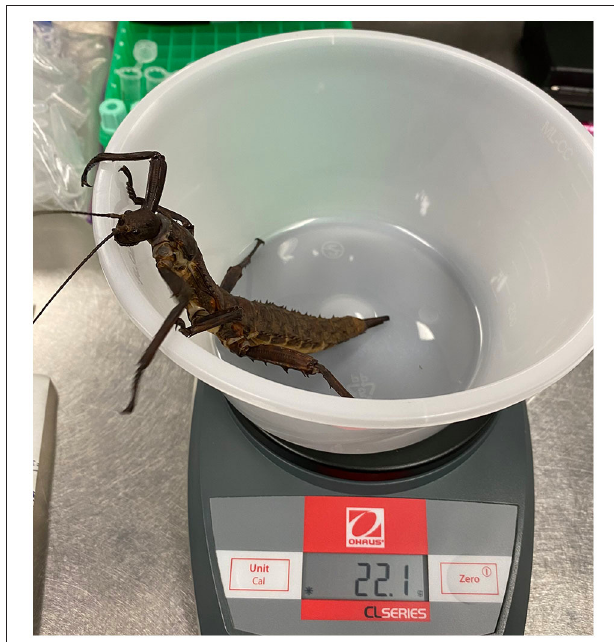
FIGURE 1 | Body weight collection in a female thorny devil stick insect ( Eurycantha calcarata ).